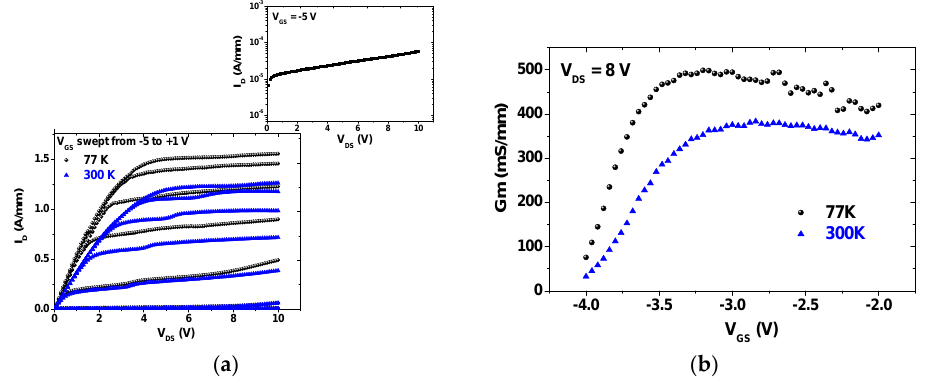
Figure 4a and Figure 4b reveal the current ‐ gain ( f T ) and power ‐ gain ( f max ) extrinsic cut ‐ off frequencies at RT and 77 K extrapolated from the current gain H21 and the unilateral power gain U Figure 3. I D ‐ V DS characteristics (the inset shows the sub ‐ threshold behavior up to 10 V in semi ‐ log Figure 3. I D - V DS characteristics (the inset shows the sub-threshold behavior up to 10 V in semi-log at V GS = − 3 V and V DS = 8 V, respectively. The values of f T / f max were derived to be 65/180 GHz and scale) ( a ) and transfer characteristics ( b ) of 0.12 × 50 μ m² AlInGaN/GaN HEMTs at RT (in blue) and scale) ( a ) and transfer characteristics ( b ) of 0.12 ˆ 50 µ m 2 AlInGaN/GaN HEMTs at RT (in blue) and 95/265 GHz at RT and 77 K, respectively. The frequency performances are clearly limited by the 77 K (in black). 77 K (in black). parasitic access resistances and thus ohmic contact resistances should be decreased in order to achieve higher cut ‐ off frequencies.